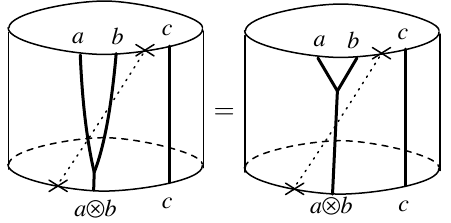
Figure 40 . Crossing the fused line over the auxiliary line should be the same with crossing two lines